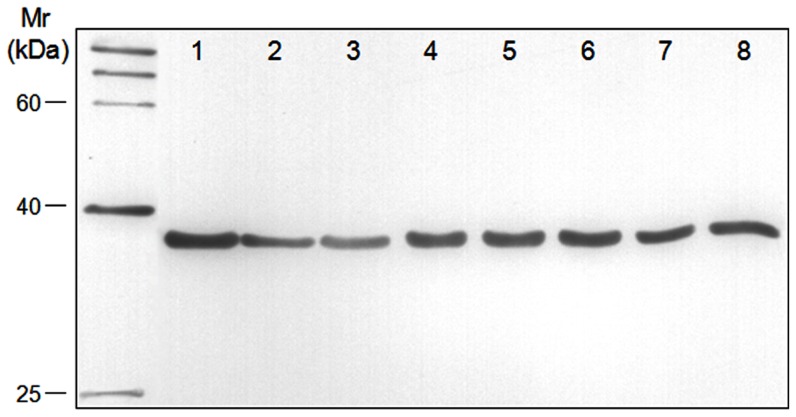
Antigenicity of PDHBs from different M. bovis isolates.The whole-cell proteins of eight M. bovis isolates were separated by SDS-PAGE, blotted onto a PVDF membrane, and subjected to Western blot analysis with a rabbit anti-rPDHB polyclonal antibody. The positions of molecular mass markers are indicated at the left in kDa. Lanes 1–8: M. bovis strain PD, PG45, SD-2, Hubei-1, HRB-1, GY-7, GY-14, and WF-3, respectively.